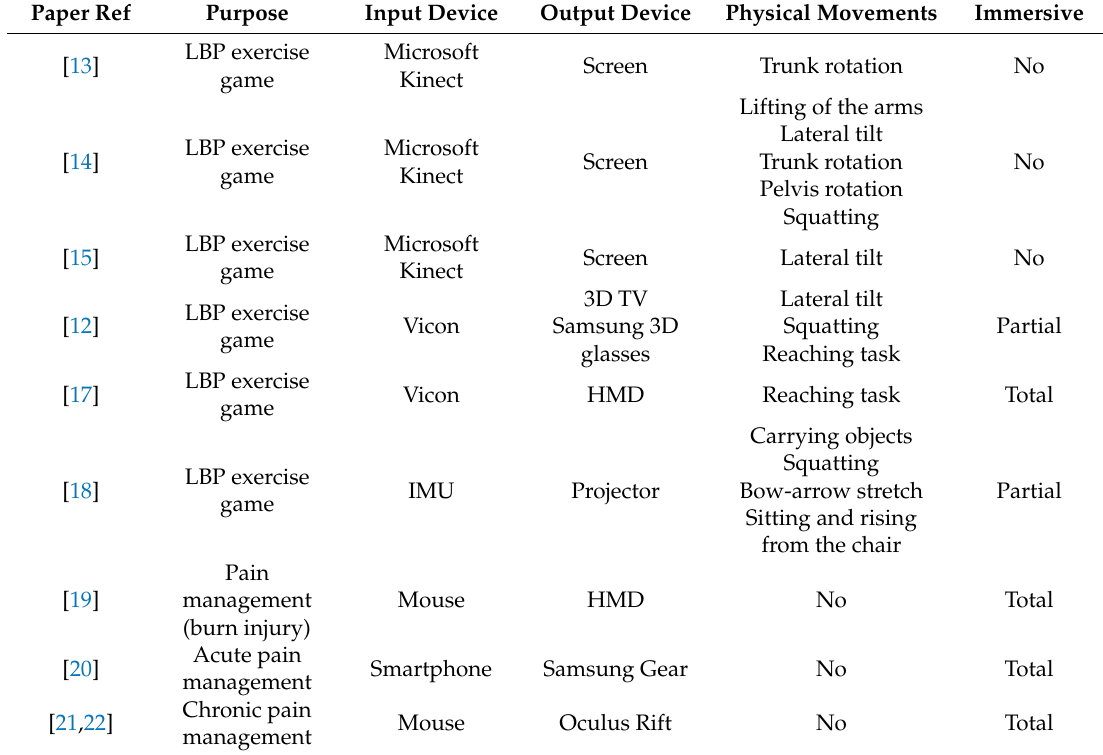
Table 1. Virtual reality (VR) interventions for low back pain (LBP) rehabilitation and pain management. Paper